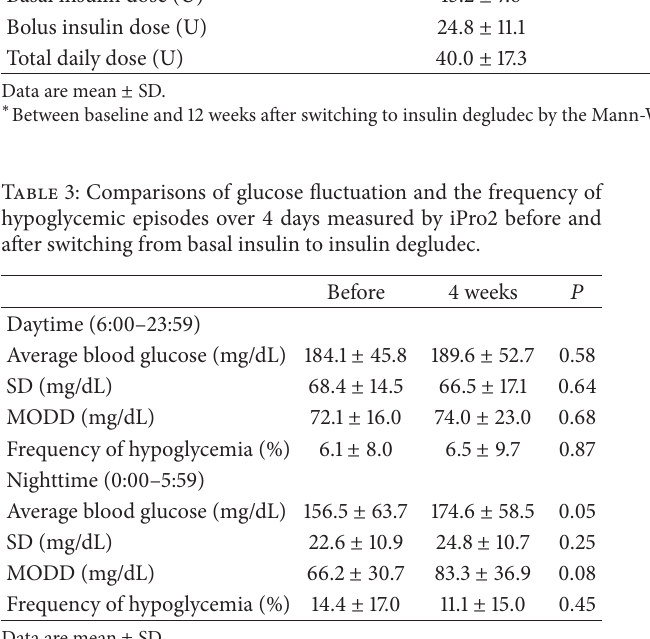
( 207.6 ± 87.7 versus 158.2 ± 90.3 mg/dL, 𝑃 < 0.01 ).